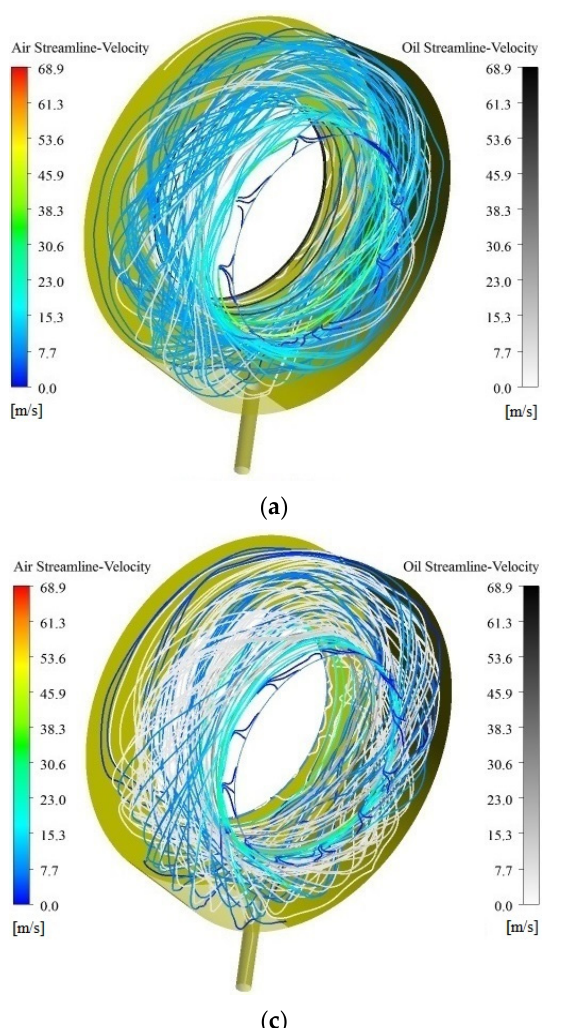
Figure 10. The streamlines of oil/gas two-phase by lubricating oil driving mode at 10,000 rpm: ( a ) t = 0.393 s; ( b ) t = 0.588 s;( c ) t = 1.137 s.